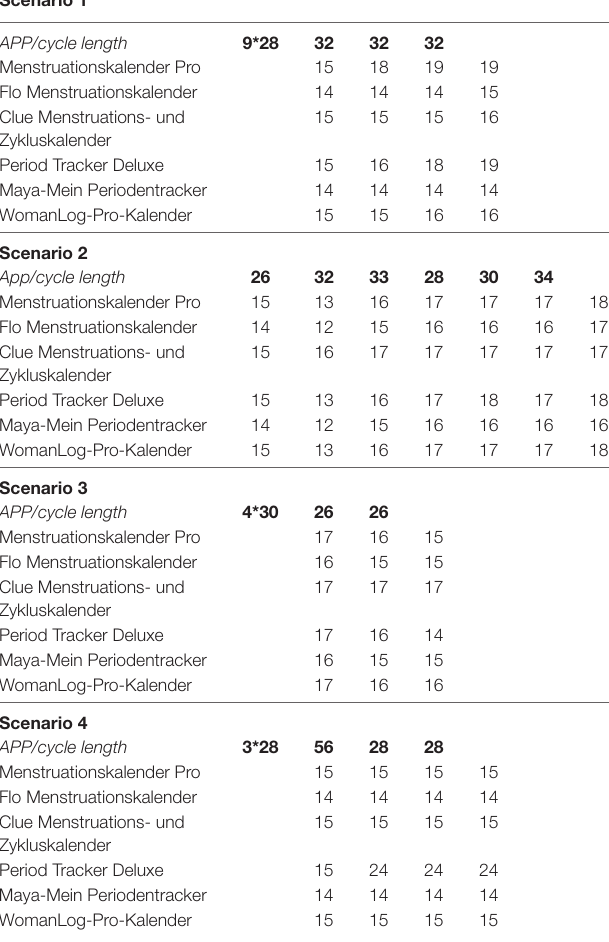
Table 3 | Test scenarios: Predicted day of